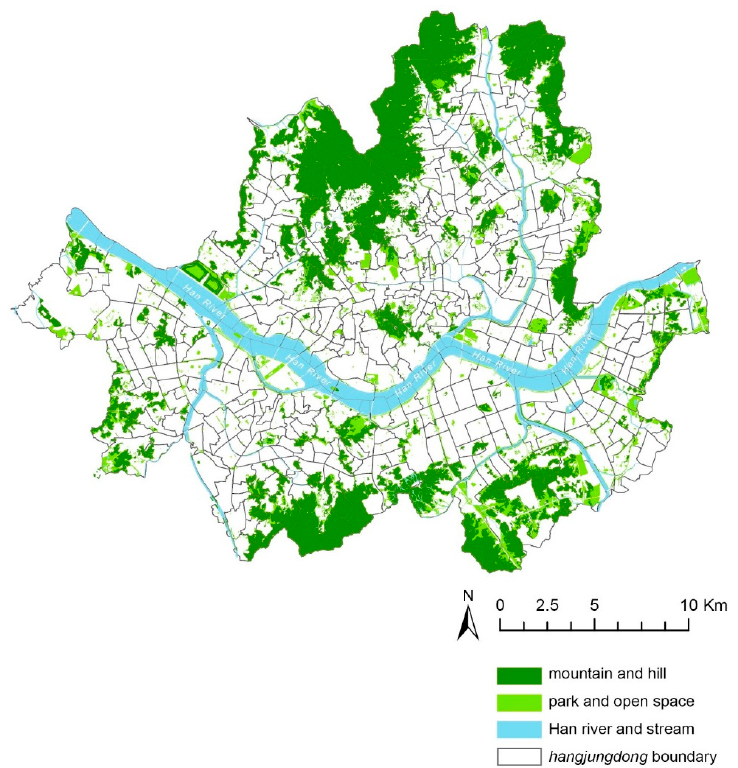
Figure 1. The study site: Seoul, South Korea.